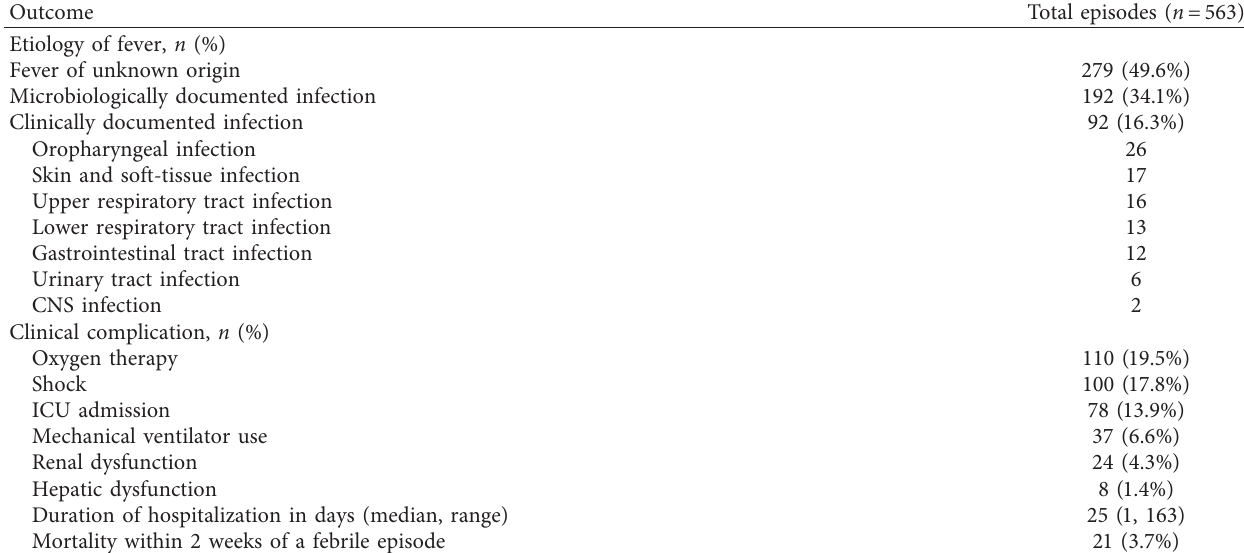
Table 3: Etiology and outcome of 563 febrile neutropenia episodes.